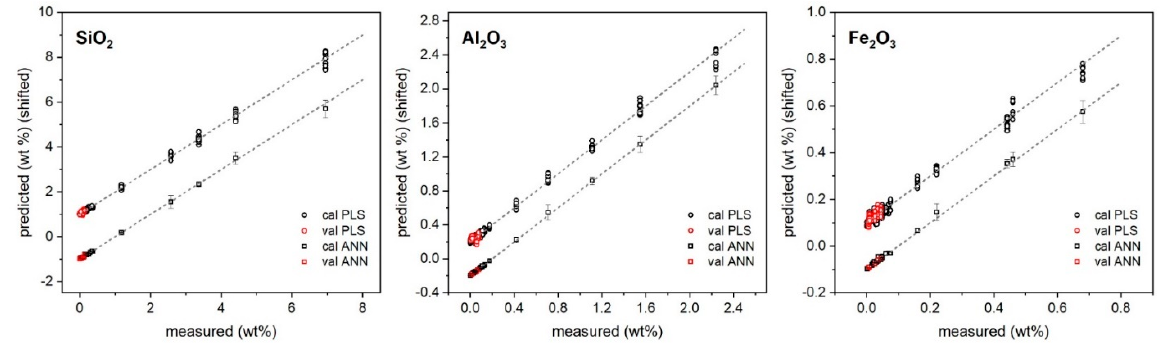
Figure 2. PLS and ANN predicted vs reference concentrations of major oxides. Plots are vertically shifted for better clarity: ± 5 (+PLS, − ANN).